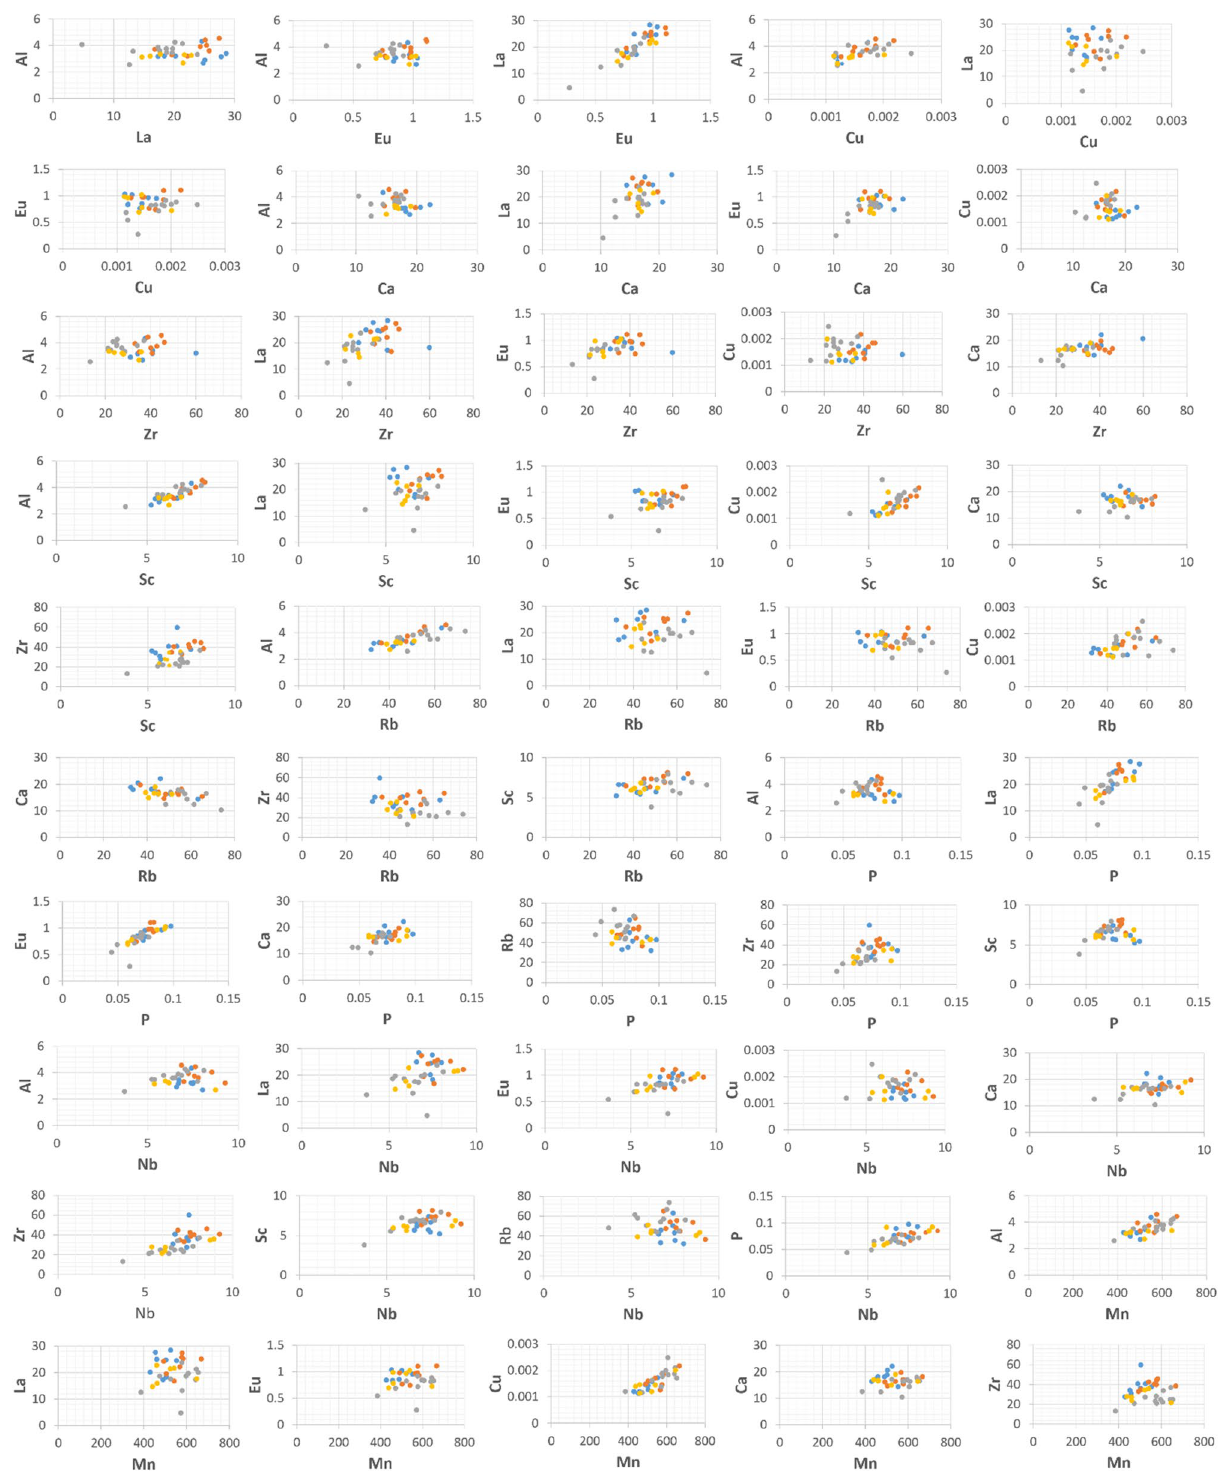
Figure 7. The bi-plots of the geochemical tracers comprising the final composite signatures selected using TRT + KW + DFA, RTM + KW + DFA, TRT + DFA + PCA and RTM + DFA + PCA for discriminating the three sub-basin spatial sediment sources. The blue, orange, grey and gold points indicate the samples collected from the western, central and eastern sub-basins and the target sediment samples,